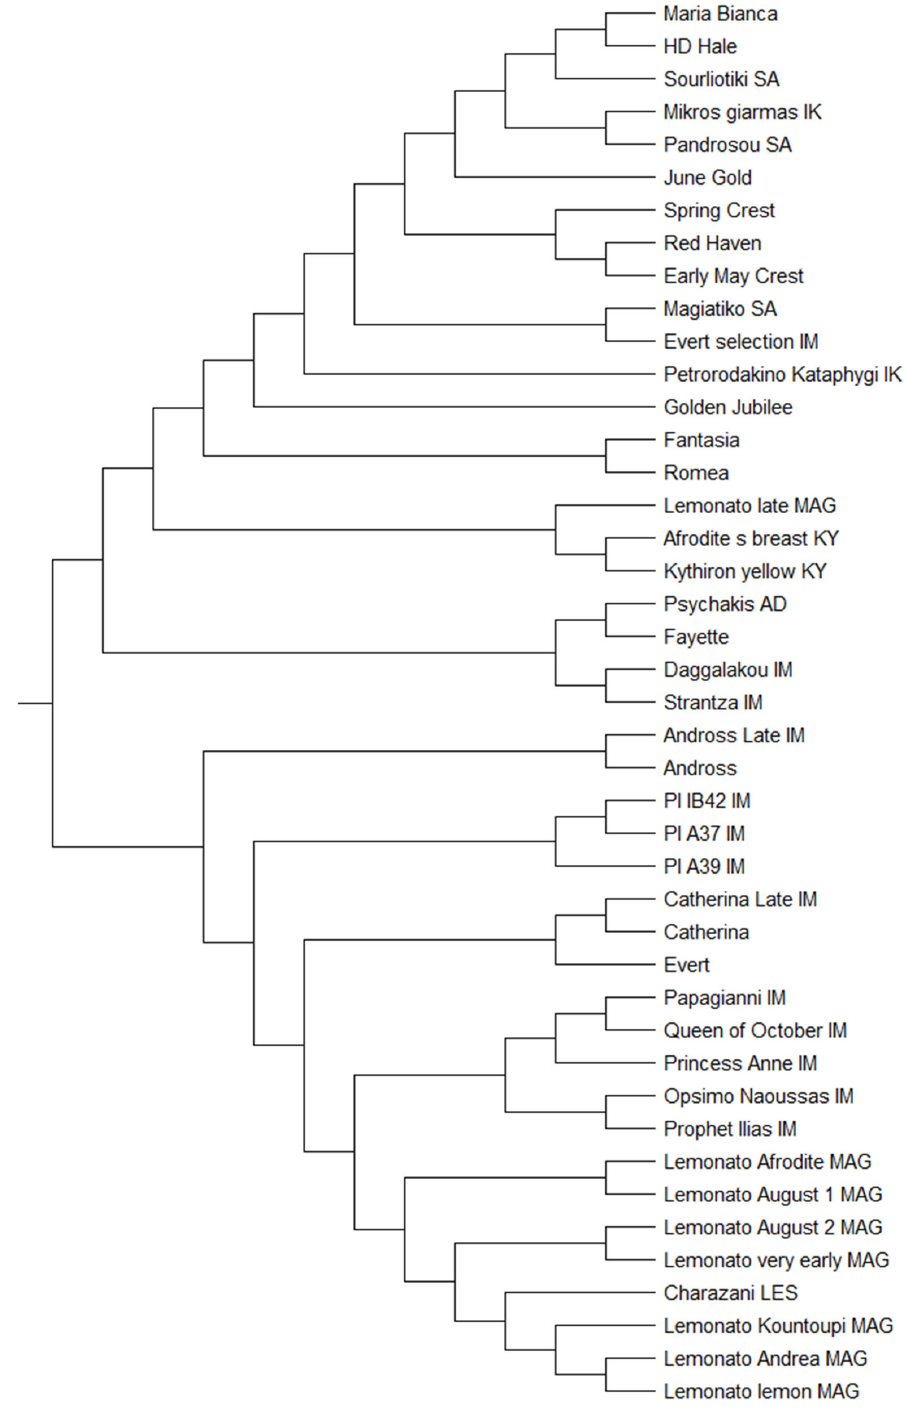
Figure 7. UPGMA dendrogram of 43 local and old foreign peach and nectarine cultivars/accessions based on eight ISSR markers. AD = Andros; MAG = Magnesia; LES = Lesvos; SA = Samos; IK = Ikaria; IM = Imathia; KY = Kythira.